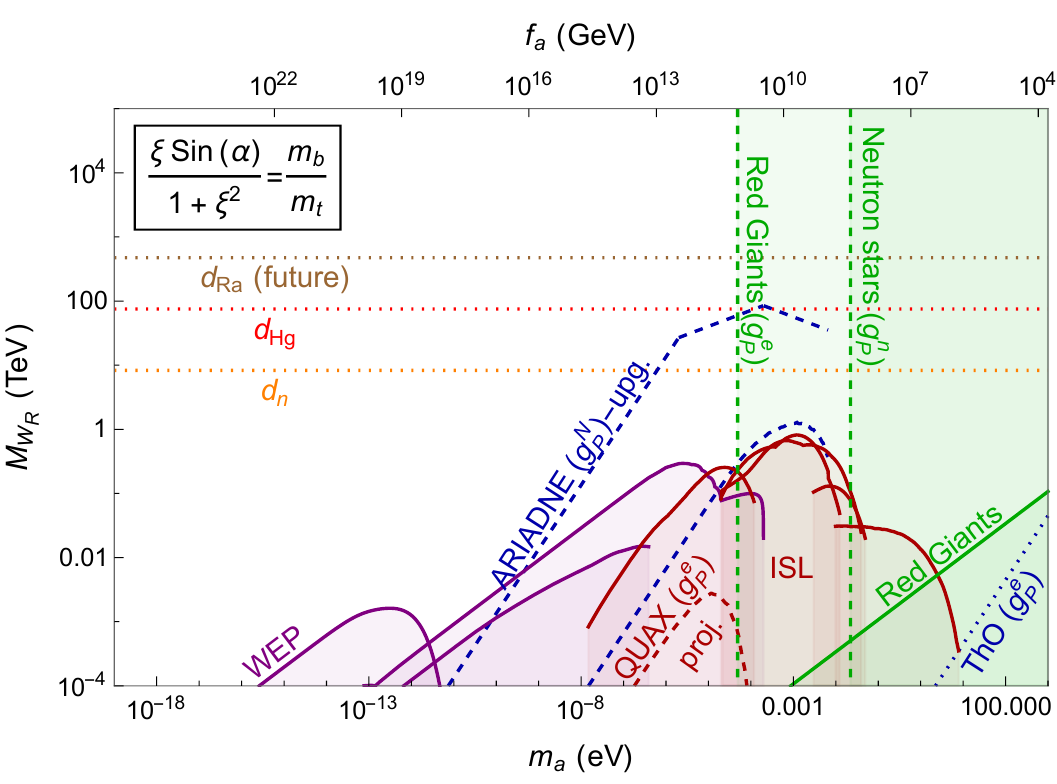
Figure 6 . Limits on the mass of right-handed gauge bosons from various experiments discussed in section 7. The labelling of the lines is explained in the caption of figure